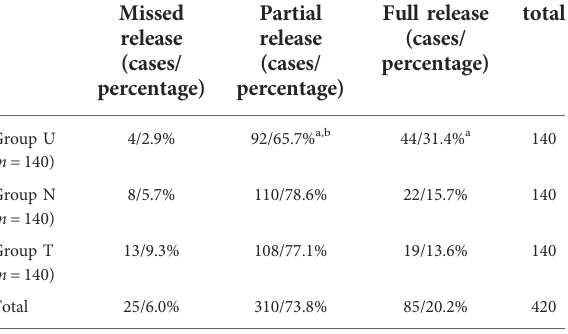
TABLE 3 The missed release cases and full release rate of three